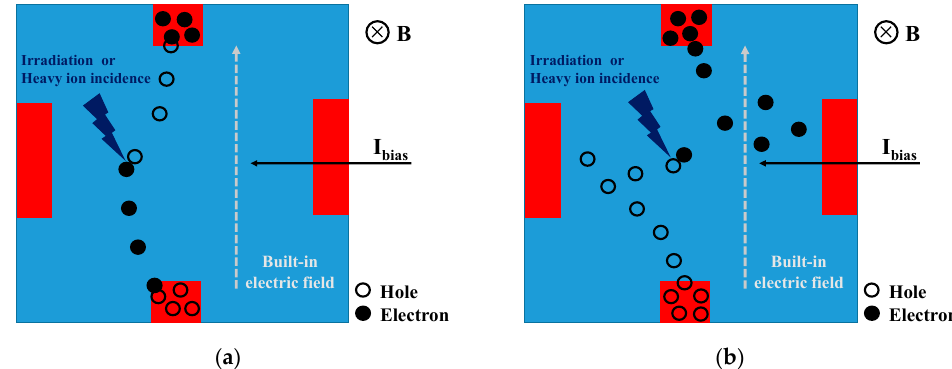
Figure 10. Illustration of the physical mechanism during ( a ) low- and ( b ) high-energy irradiation at the X-Y cross section of the silicon film.